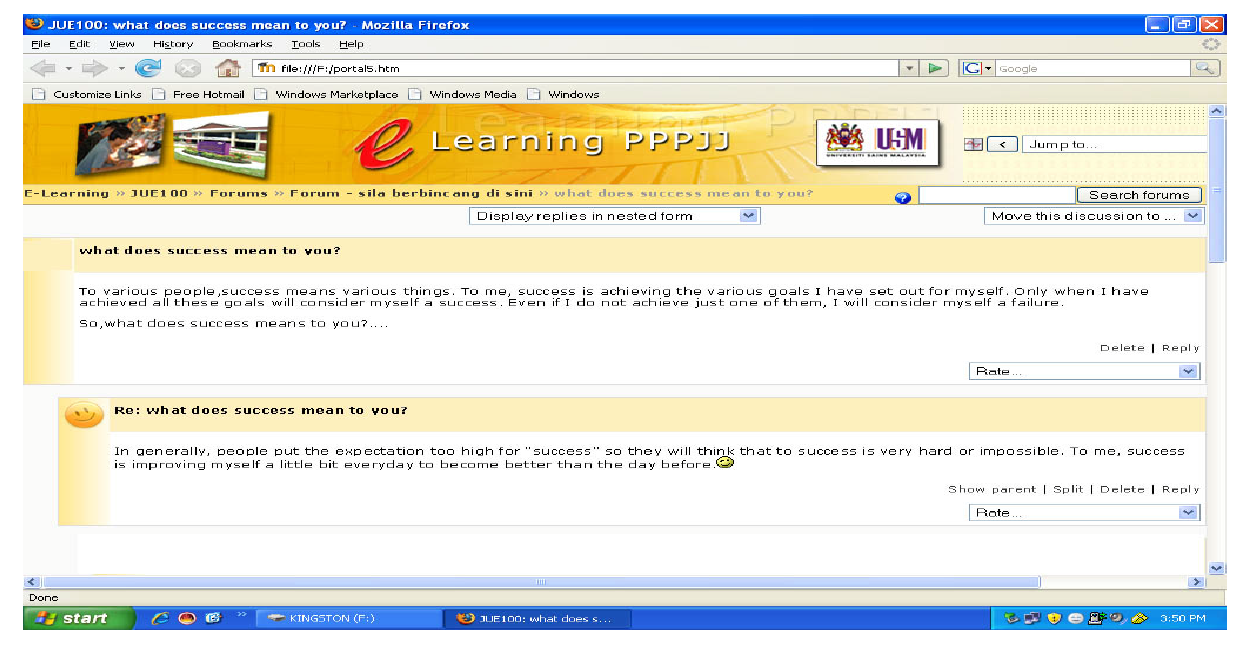
Figure 2 . Samples of student